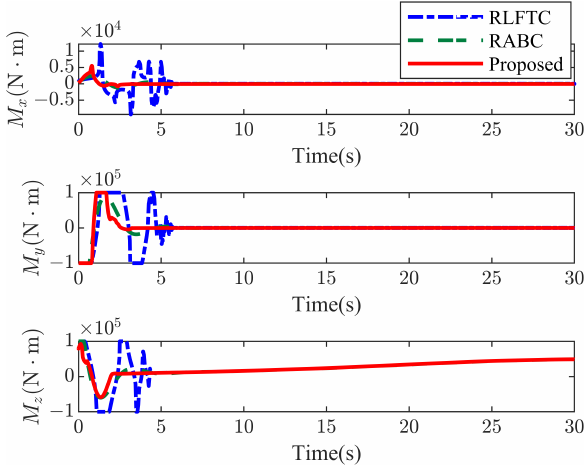
Figure 8. Time histories of the control torques.